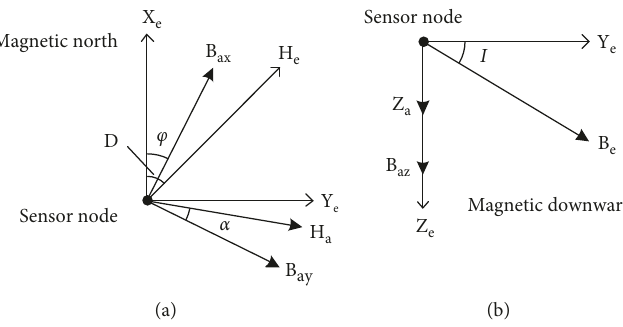
Figure 5: (a) Horizontal x - y plane magnetic fields; (b) vertical z - y plane magnetic